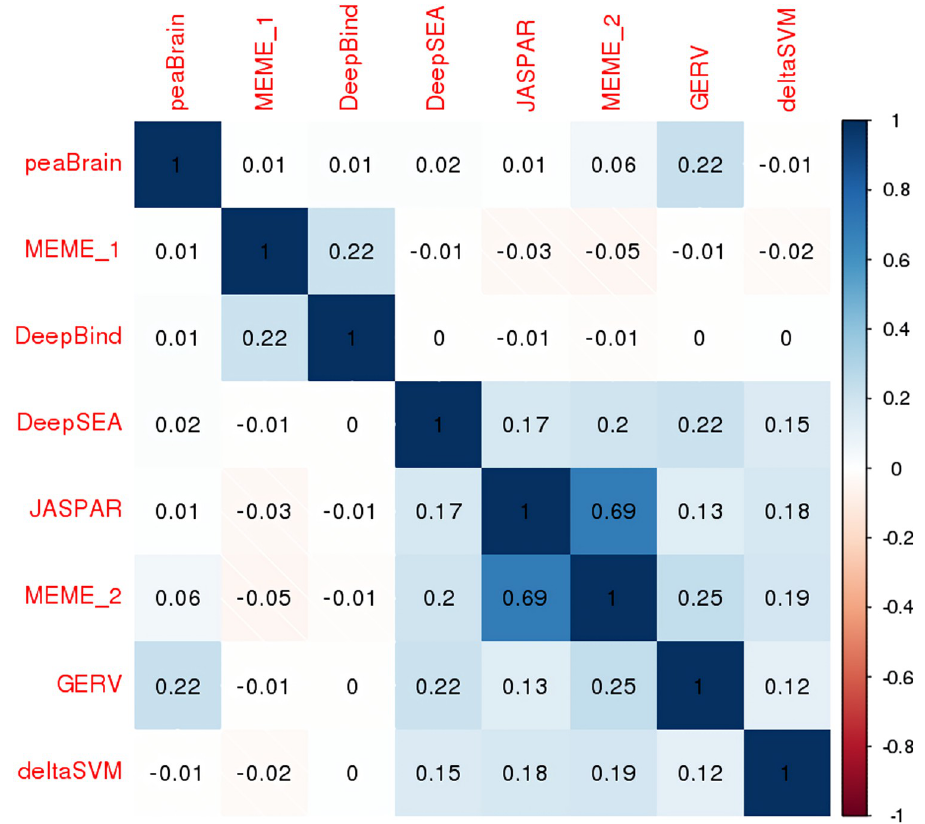
Fig 5. Rank correlation plot for TF-binding algorithms and the peaBrain impact score. JASPAR, MEME_1 and MEME_2 are PWM-approaches.